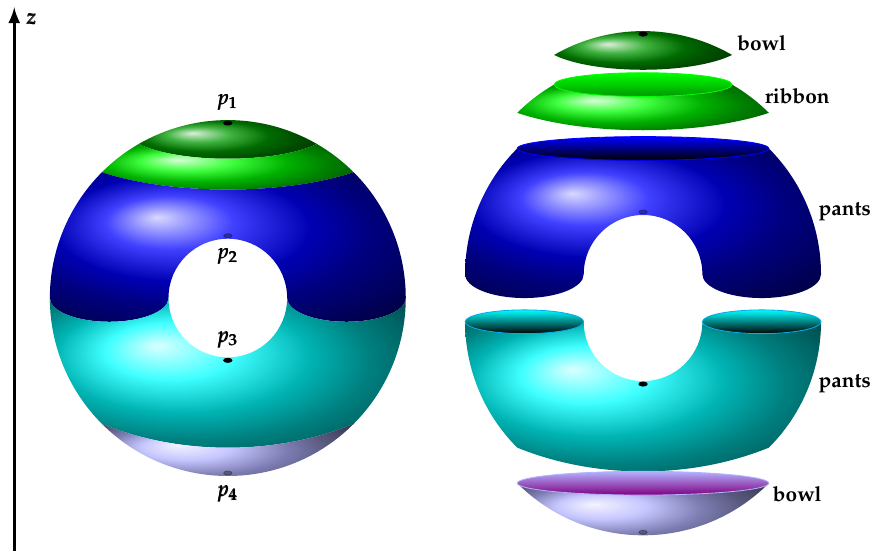
Figure 9. A torus is cut in pieces with different topologies. Notice that the ribbon can be pasted to the bowl or to the pants without change the topology neither of the bowl or the pants: cutting away pieces not containing critical points does not change the